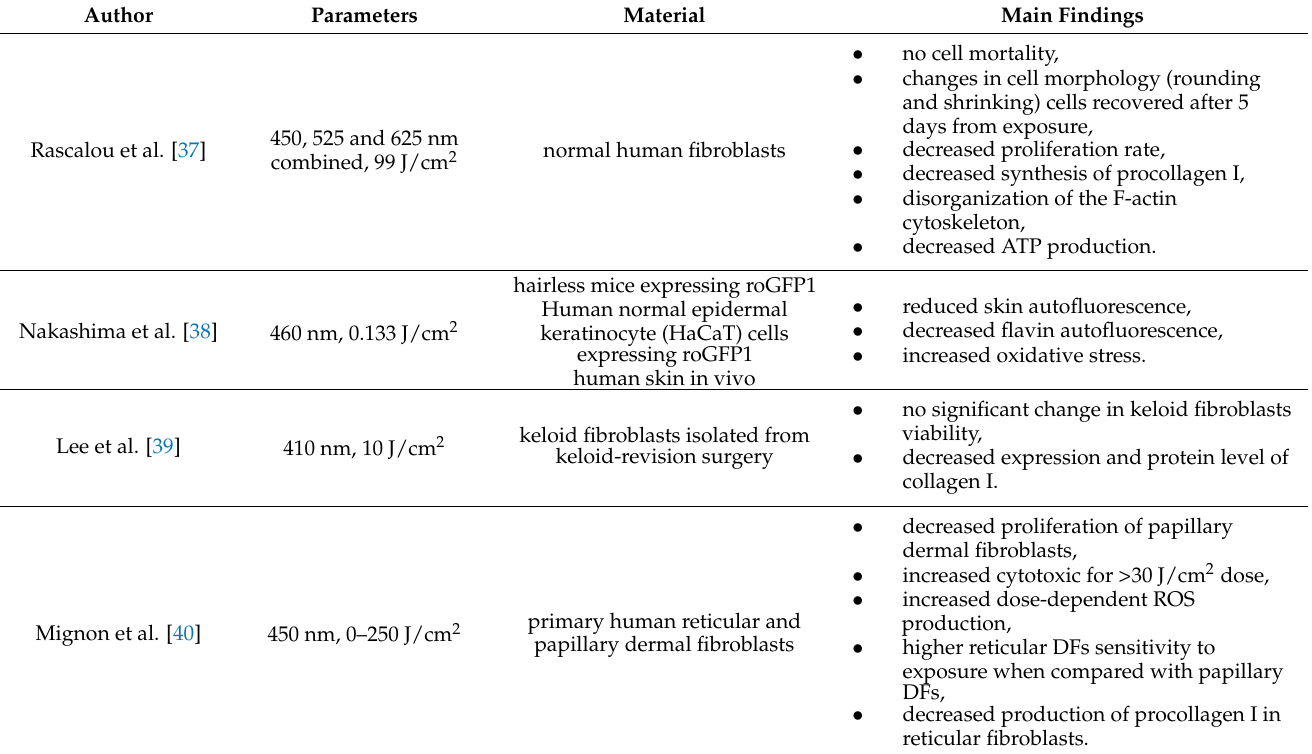
Table 2. Blue light (450–495 nm) effects on skin